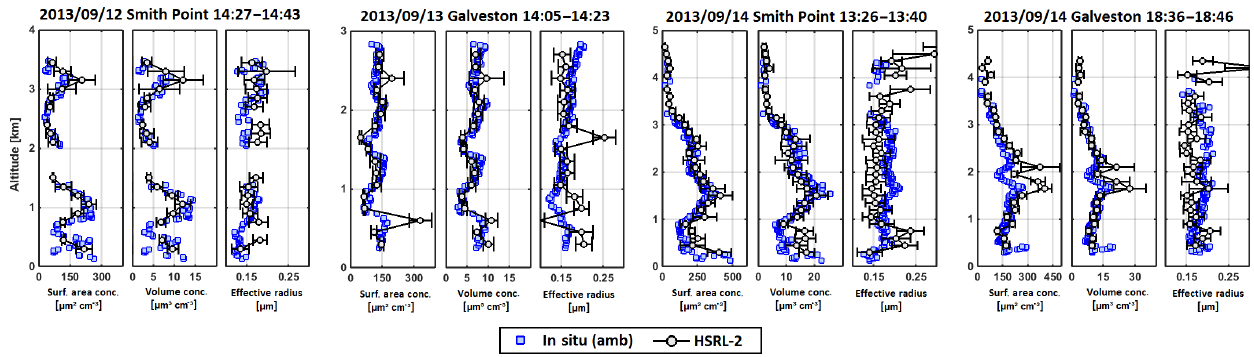
Figure 5. Examples of profile-to-profile comparisons between HSRL-2 fine-mode retrievals and in situ measurements (corrected for ambient RH) of surface-area and volume concentrations, and effective radius obtained during DAQ TX. The error bars represent the uncertainties of the HSRL-2